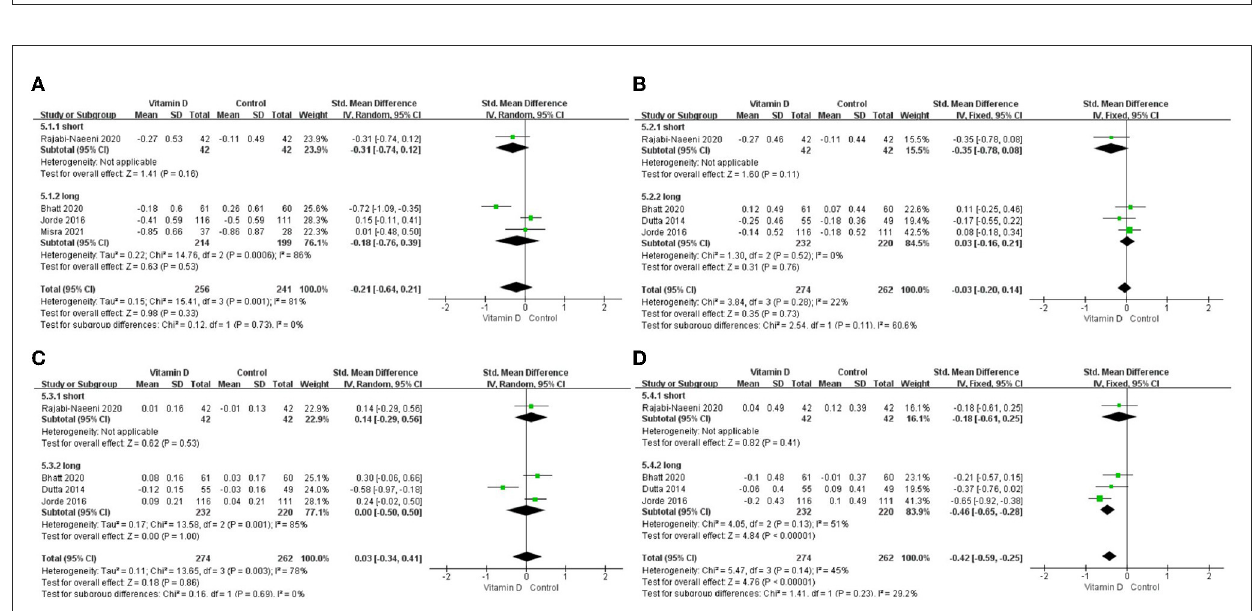
FIGURE7 Subgroup analysis by intervention duration. (A) TC, (B) LDL-C, (C) HDL-C, and (D) TG. TC, total cholesterol; LDL-C, low-density lipoprotein cholesterol; HDL-C, high-density lipoprotein cholesterol; TG, triglyceride.